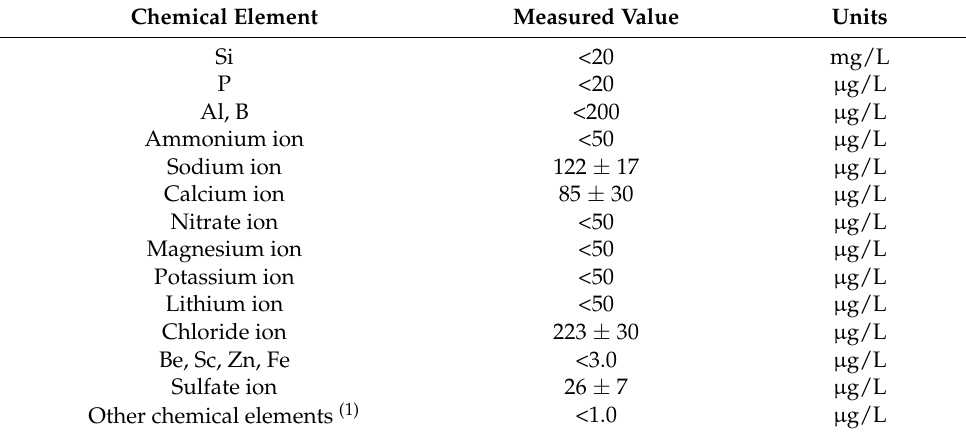
Table 4. Results of analysis of ions and elemental compounds from purified seawater before use in the electrolyser. (1) Other chemical elements include V, Cr, Mn, Fe, Co, Ni, Cu, Zn, Ga, Ge, As, Se, Br, Rb, Sr, Zr, Nb, Mo, Ru, Rh, Pd, Ag, Cd, In, Sn, Sb, Te, I, Cs, Ba, La, Ce, Pr, Nd, Sm, Eu, Gd, Tb, Dy, Ho, Er, Tm, Yb, Lu, Hf, Ta, W, Re, Os, Ir, Pt, Au, Hg, Tl, Pb, Bi, Th, U. Chemical